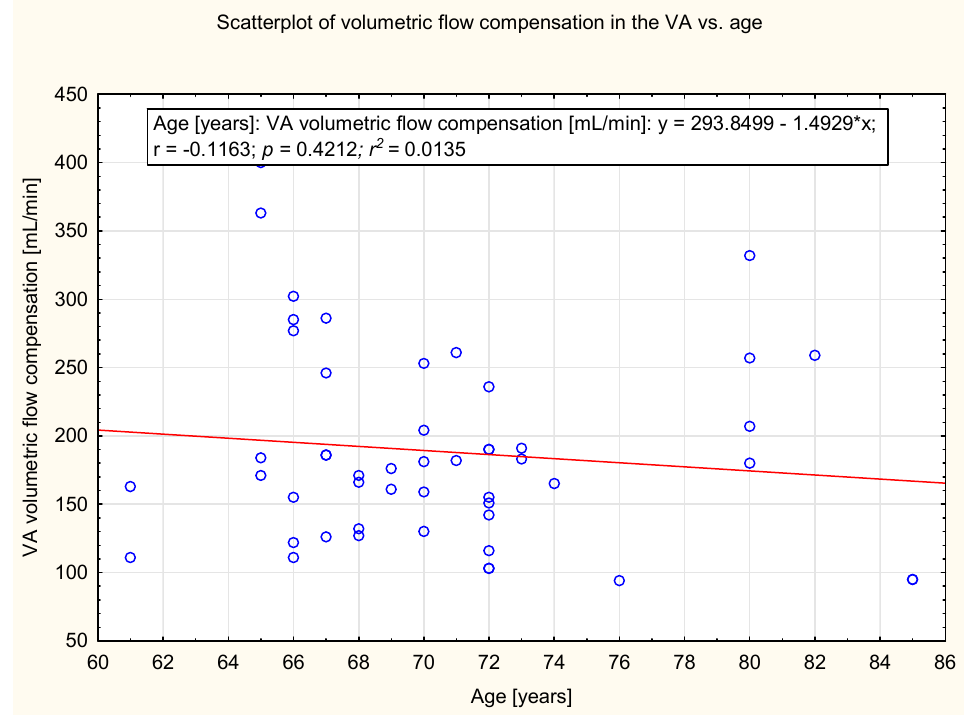
Figure 7. Scatter plot of the volumetric flow compensation in VA and age (y = 293.8499 − 1.4929*x). No correlation was observed ( p = 0.42).